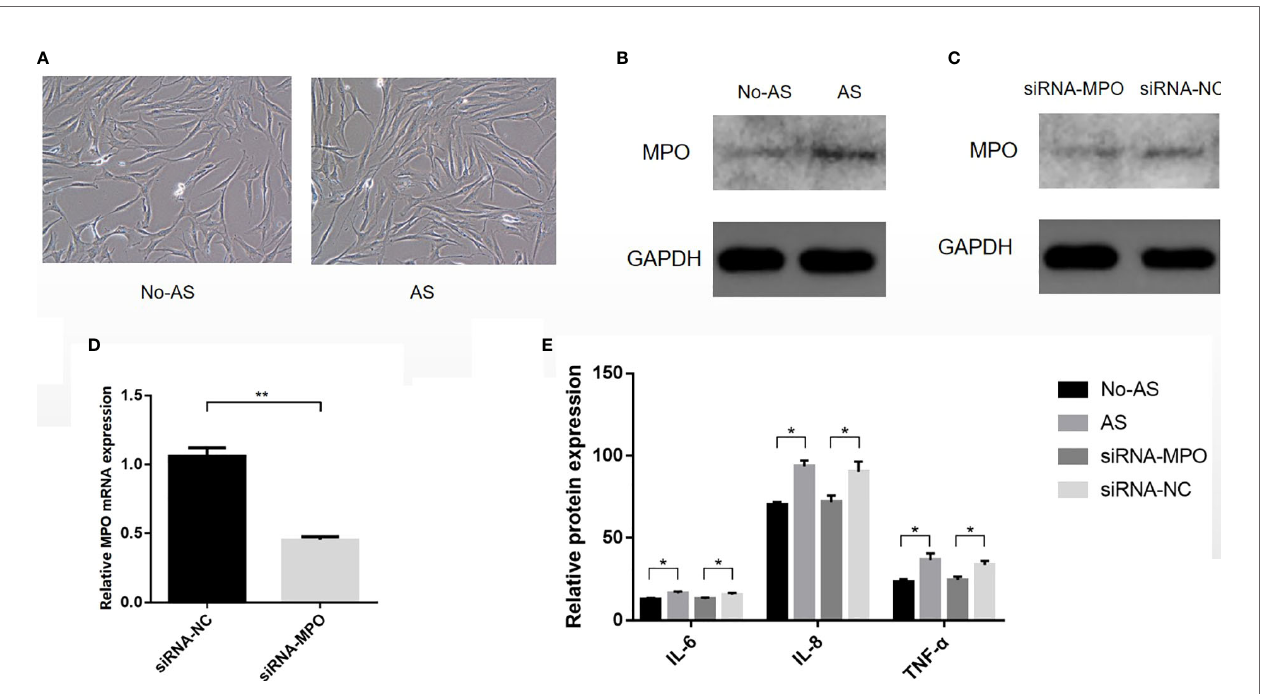
FIGURE 10 | The cells were isolated from the tissue, cultured, and then transfected (A) . Western blot analysis showed that the expression of MPO in AS group was higher than that in NO-AS group (P < 0.05) (B) . After transfection, the mRNA and protein expressions of MPO in siRNA-MPO group were lower than those in siRNA-NC group (P < 0.05) (C, D) . ELISA analysis showed that the expression levels of IL-6, IL-8, and TNF- a in AS group were higher than those in NO-AS group (P < 0.05). The expression levels of IL-6, IL-8, and TNF- a in siRNA-MPO group were lower than those in siRNA-NC group (P < 0.05) (E) . *P < 0.05, **P <